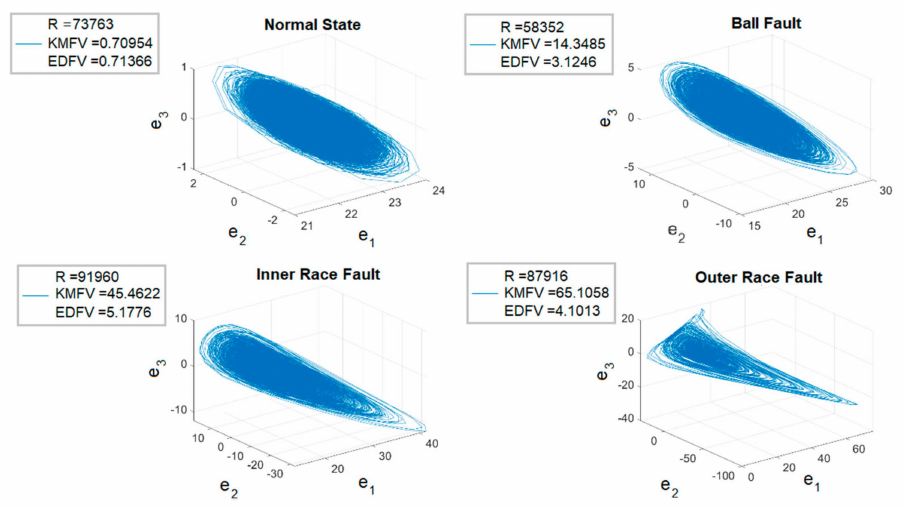
Figure 10. The experimental results for the training stage—3D phase portraits. KMFV, K-means-based feature value; EDFV, Euclidean distance feature